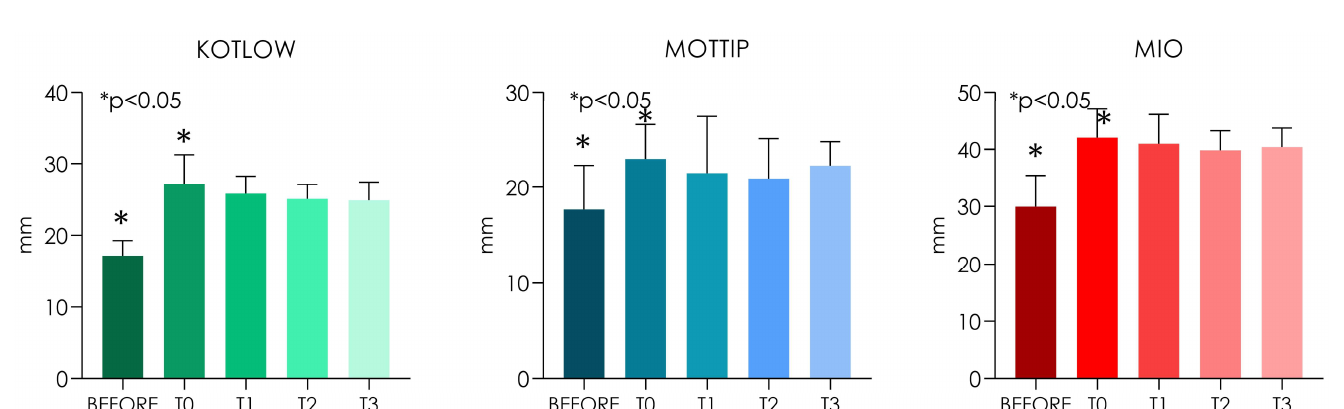
Figure 5. Chart of the Kotlow’s free-tongue measurement, MOTTIP and MIO at T 0 , T 1 , T 2 and T 3 (One-Way ANOVA Tukey’s post hoc). Table 3. Summary of the One-Way ANOVA Tukey ’ s multiple comparisons post hoc test.